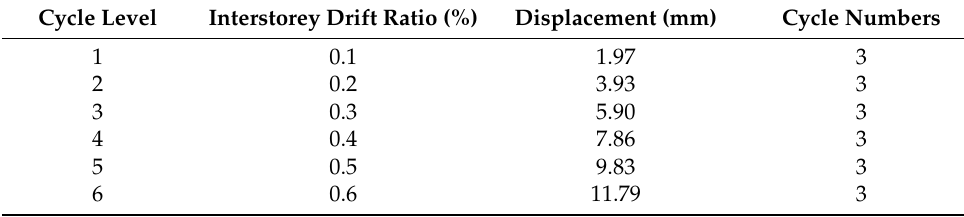
Table 6. Imposed displacement